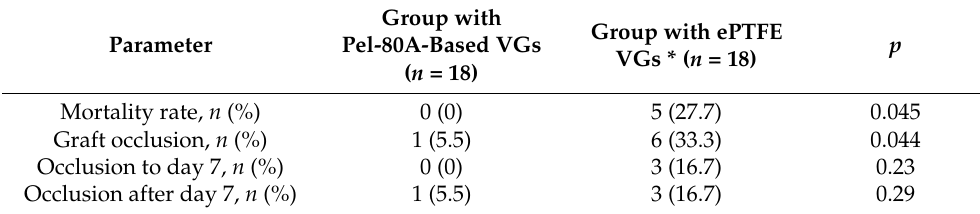
Table 3. Postoperative complications in the studied groups during the observation period.